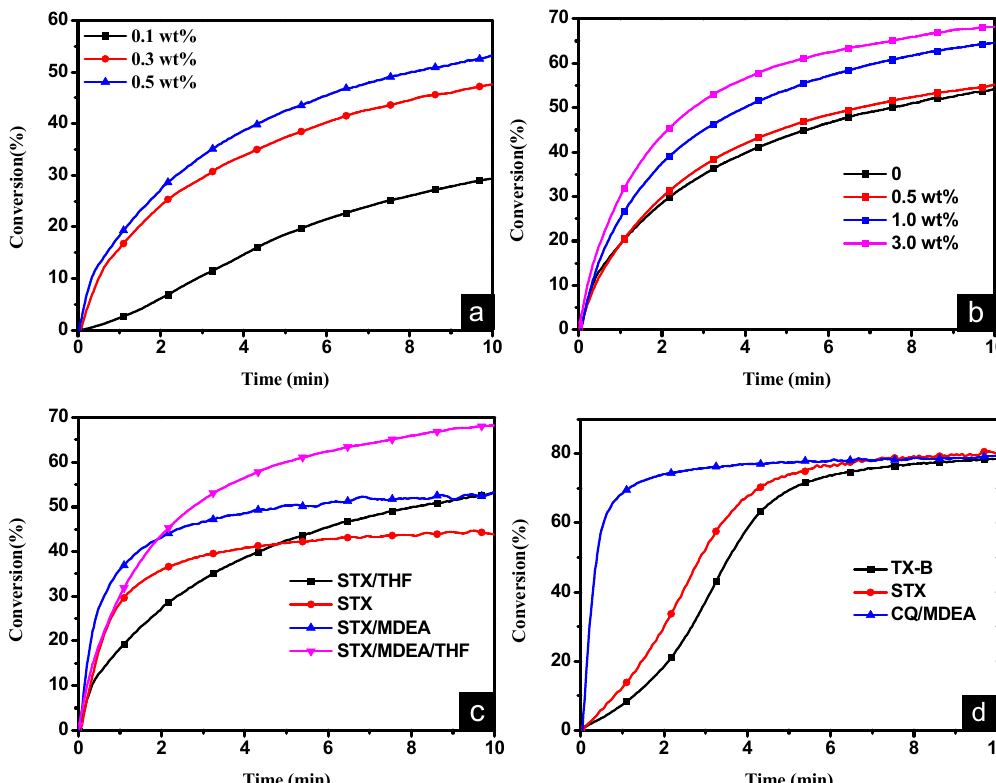
Figure 2. Conversion-time for polymerization of TMPTA in laminate ( a ): initiated by STX with different concentrations ([THF] = 25 wt %); ( b ): initiated by STX with different MDEA concentrations ([STX] = 0.5 wt%, [THF] = 25 wt %). ( c ): initiated by STX in the presence of MDEA and THF or not. ([STX] = 0.5 wt%, [MDEA] = 3 wt %, [THF] = 25 wt %). ( d ): initiated by STX, TX-B and CQ/MDEA. [TX-B] = [CQ] = 3 × 10 − 5 mol/g, [STX] = 3 × 10 − 5 mol g − 1 , [MDEA] = 2 × 10 − 4 mol/g, I = 28 mW cm − 2